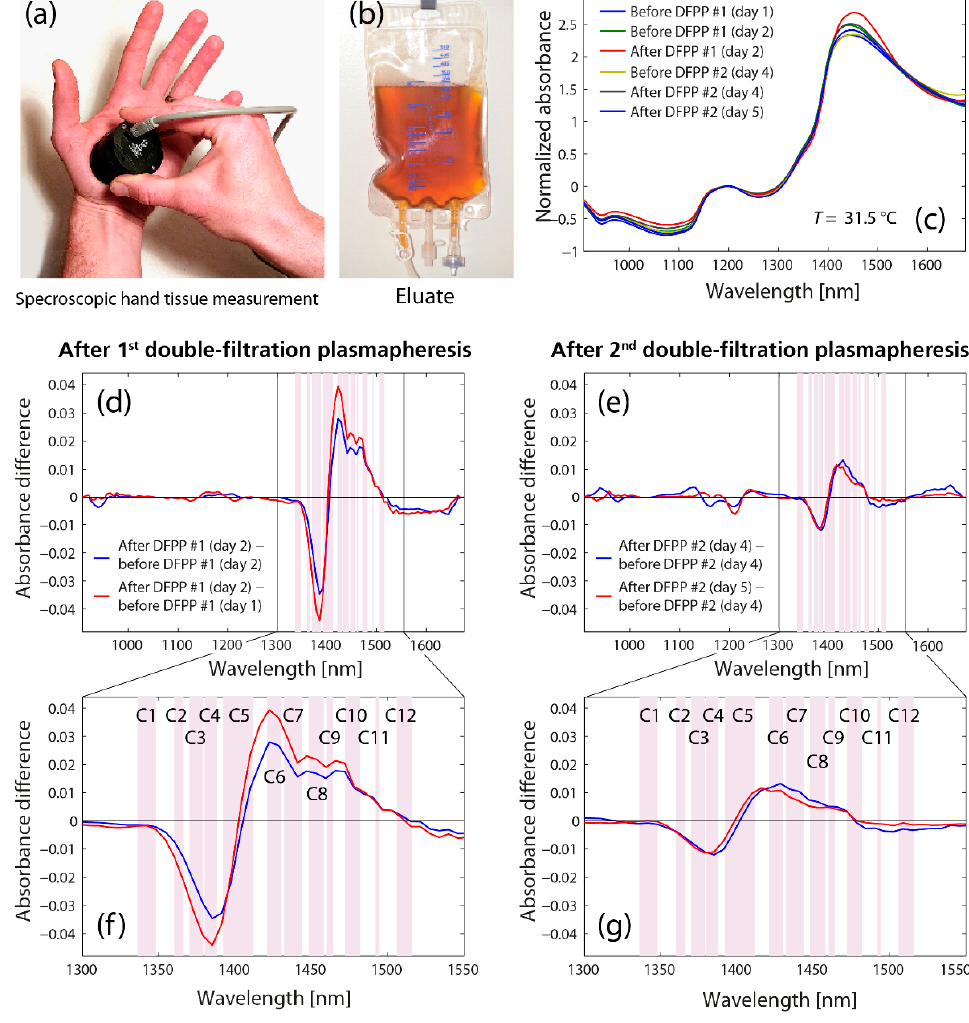
Figure 1. ( a ) Measurement performed on the palm of the left hand. ( b ) Bag with eluate extracted during the first DFPP treatment. The yellowish-brown color is striking, which is due to a high con- centration of filtered substances. Normal blood plasma is clearer and more yellowish. ( c ) Raw spec- tra. ( d ) and ( e ) Difference spectra of the tissue measurements after the first ( 𝐗 (cid:2888)(cid:2919)(cid:2916)(cid:2916)(cid:2869)(cid:2929)(cid:2930) (cid:2888)(cid:2890)(cid:2900)(cid:2900) (A (cid:2869) ) , 𝐗 (cid:2888)(cid:2919)(cid:2916)(cid:2916)(cid:2869)(cid:2929)(cid:2930) (cid:2888)(cid:2890)(cid:2900)(cid:2900) (A (cid:2870) ) ) and second (( 𝐗 (cid:2888)(cid:2919)(cid:2916)(cid:2916)(cid:2869)(cid:2929)(cid:2930) (cid:2888)(cid:2890)(cid:2900)(cid:2900) (B (cid:2869) ) , 𝐗 (cid:2888)(cid:2919)(cid:2916)(cid:2916)(cid:2869)(cid:2929)(cid:2930) (cid:2888)(cid:2890)(cid:2900)(cid:2900) (B (cid:2870) ) ) DFPP treatment. ( f , g ) show zoomed-in regions with the 12 WAMACS. A listing of the WAMACS with the corresponding water properties can be found in Table 1 in Muncan et al. [79].